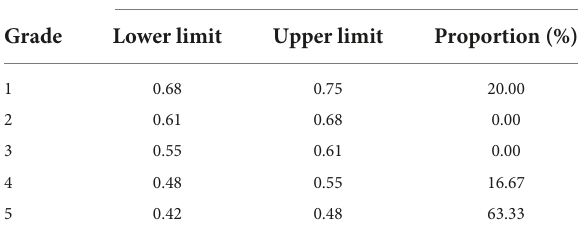
TABLE 2 Soil quality grade classification of different evaluation